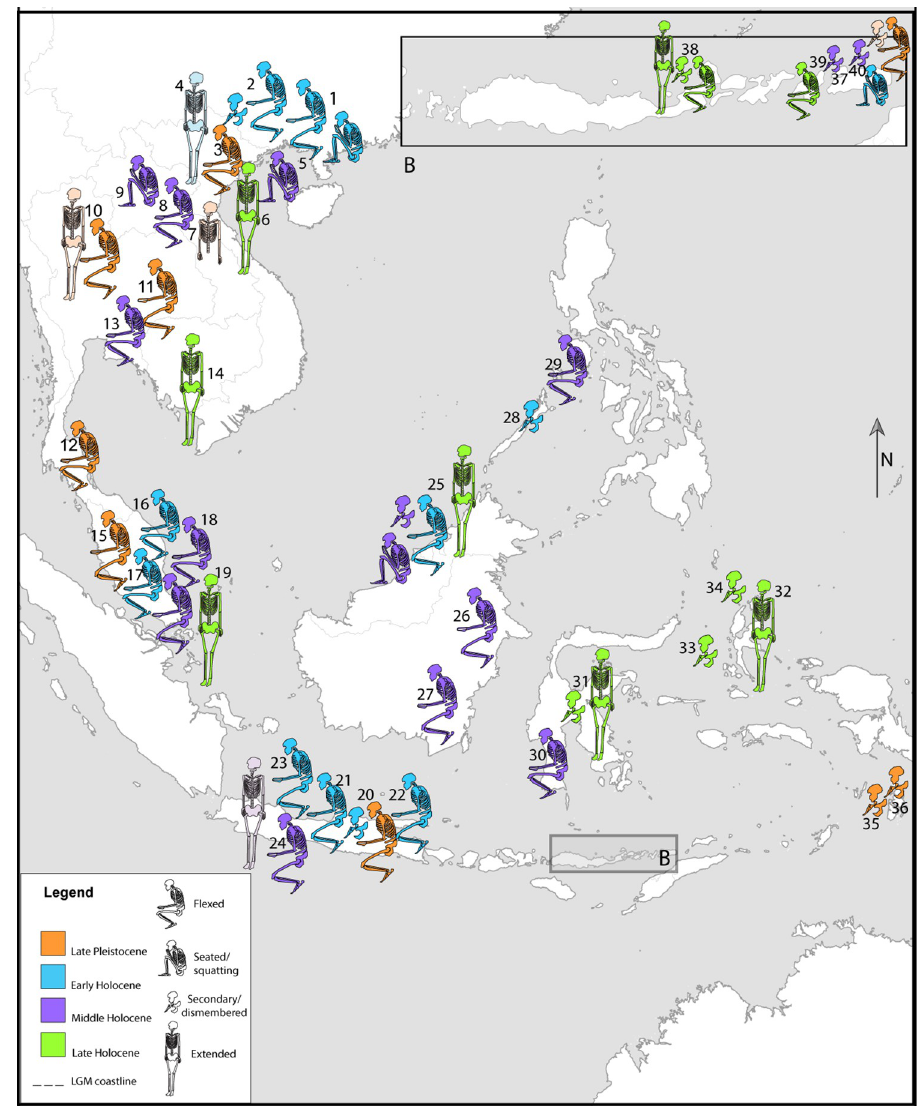
Fig 1. Sites map. Geographic distribution of sites with human burials described in the text. For site numbers, refer to S1 Table. Basemap made with Natural Earth. Free vector and raster map data @